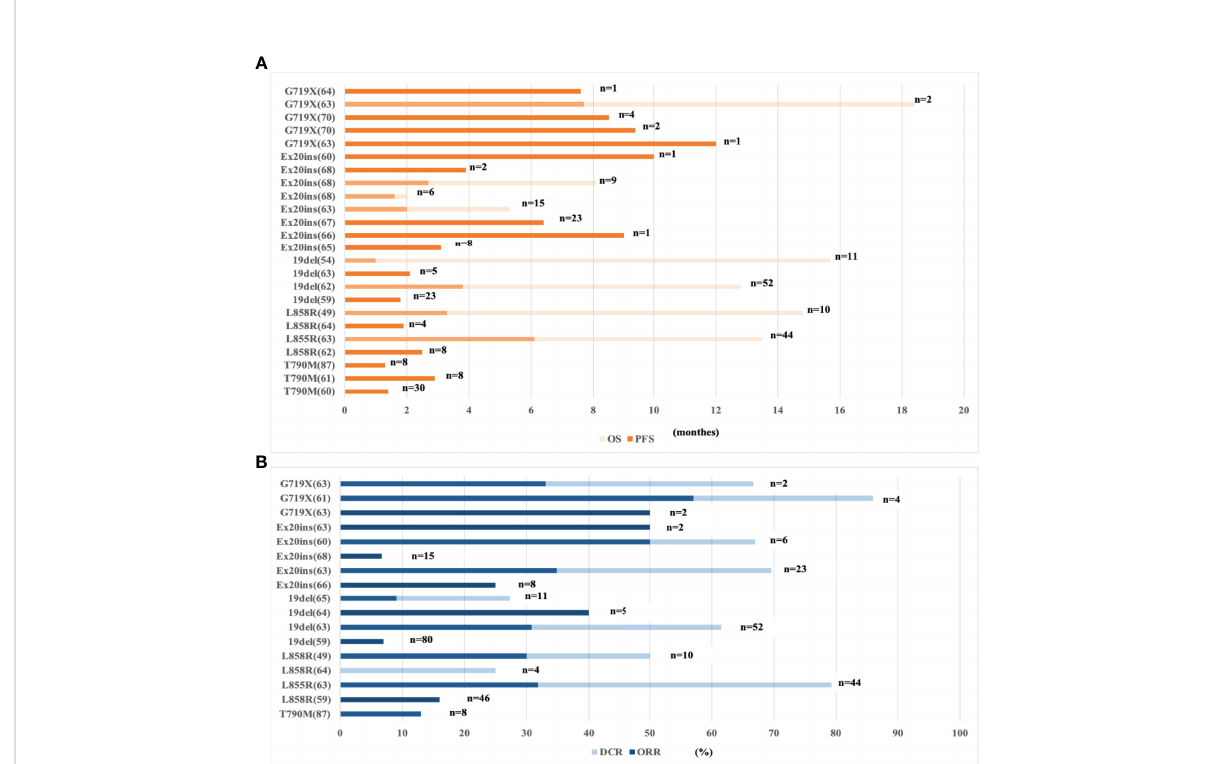
FIGURE 1 Clinical data of ICI-based immunotherapy for subtypes of EGFR-mutant NSCLC patients. (A) The PFS and OS of ICI-based immunotherapy for subtypes of EGFR-mutant NSCLC. (B) The ORR and DCR of ICI-based immunotherapy for subtypes of EGFR-mutant NSCLC. NSCLC, non-small- cell lung cancer; EGFR, epidermal growth factor receptor; n, No. of EGFR mutant patients; ORR, overall response rate; DCR, disease control rate; OS, overall survival; PFS, progression-free survival; ICIs, immune checkpoint inhibitors; 19del, exon 19 deletion; Ex20 ins, exon 20